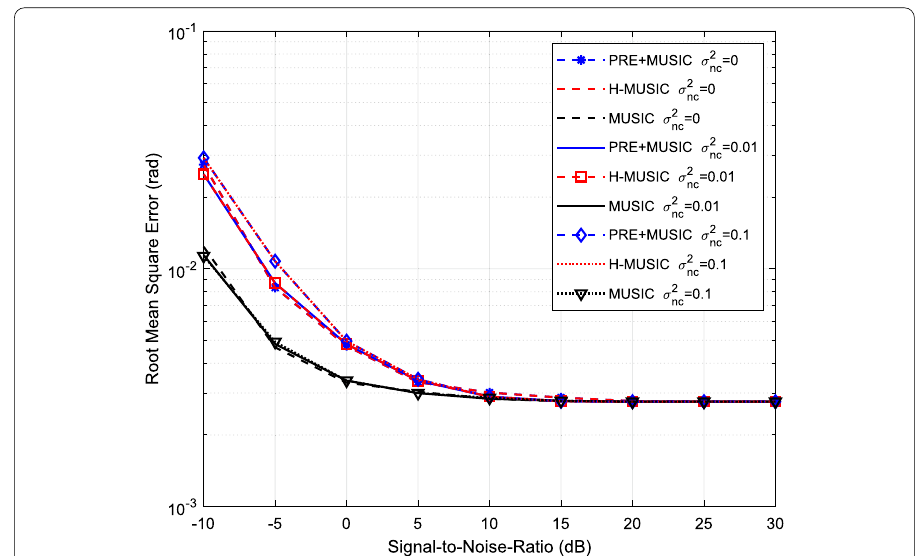
Fig. 5 RMSE of AoA estimation for the partially connected architecture, M c = 500 , S 1 = 20 , S 2 = 80 , (cid:31) = 1cm